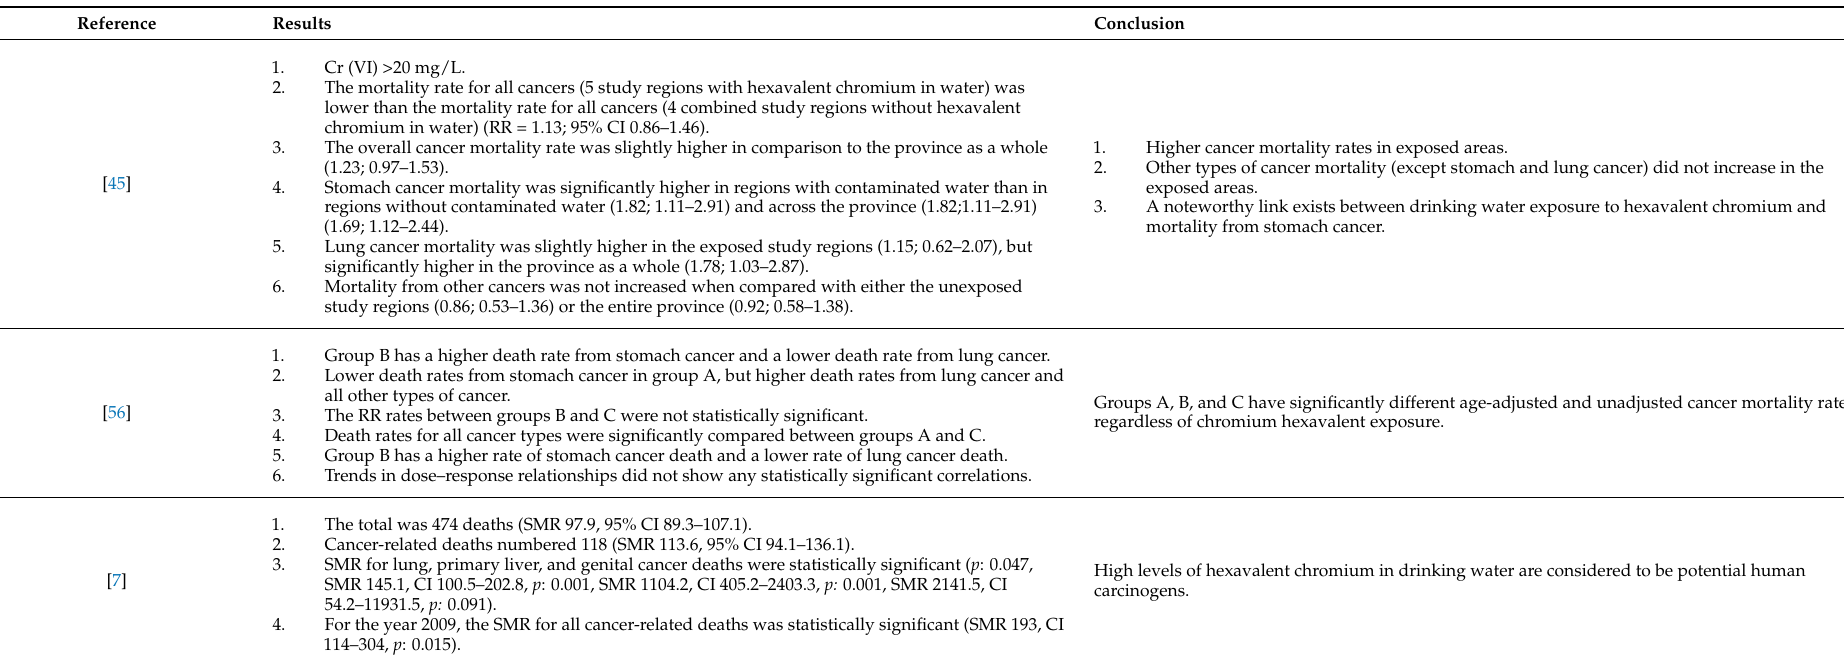
Table 8. Results and conclusions of the selected ecological studies included in the systematic